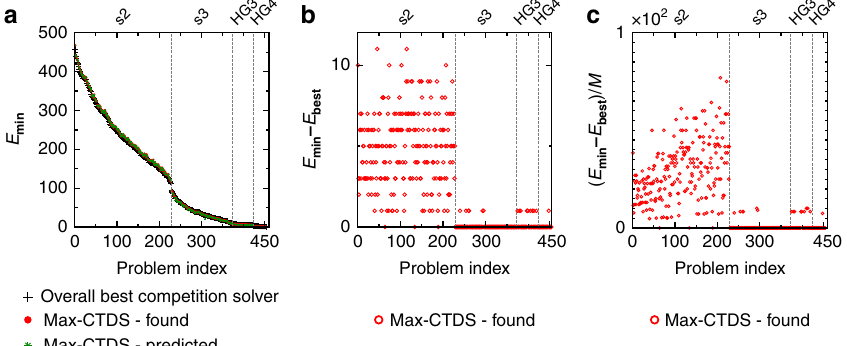
Fig. 5 Algorithm performance on competition MaxSAT problems. a Using the 454 random benchmark problems from the 2016 SAT competition 49 , we compared the overall best (lowest) energy found by the competition solvers (black + symbols) and the minimum found/predicted by our Max-CTDS. There are four categories of problems, separated by vertical dashed lines: “ s2 ” (Abrame-Habet) are Max 2-SAT with N ∈ [100, 200], M ∈ [1200, 2600]; “ s3 ” (Abrame-Habet) are Max 3-SAT with N ∈ [70, 110], M ∈ [700,1500]; “ HG3 ” (high-girth) are Max 3-SAT problems with N ∈ [250, 300], M ∈ [1000, 1200], and “ HG4 ” are Max 4-SAT problems with N ∈ [100, 150], M ∈ [900, 1350]. b There are some small energy differences especially in the “ s2 ” category, where the ODEs are more stiff and the integration becomes very slow. c The energy differences normalized by the number of clauses, ( E min − E M . Max-CTDS solves all problems within 0.8% of the best energy value best )/ NATURE COMMUNICATIONS| (2018) 9:4864 |DOI: